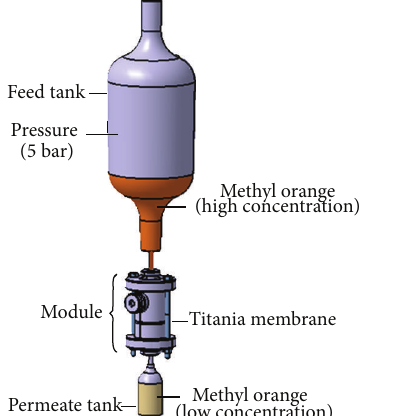
Figure 2: Schematic image of a membrane setup with a dead-end filtration cell used for filtration